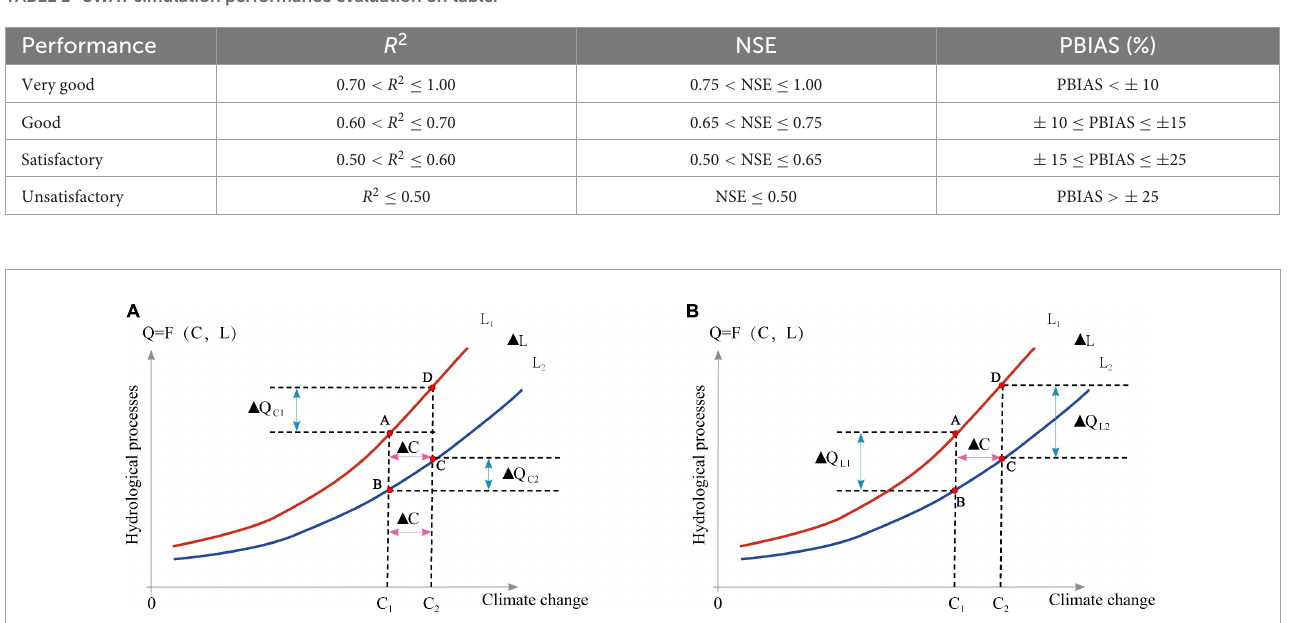
TABLE 1 SWAT simulation performance evaluation on table.